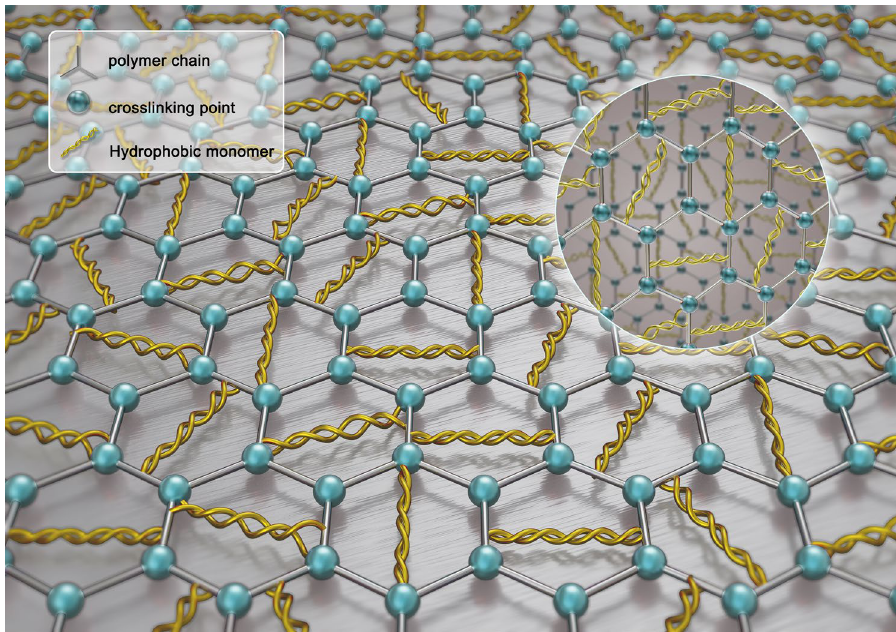
Figure 1. "Mesh-Lock" simulation diagram of